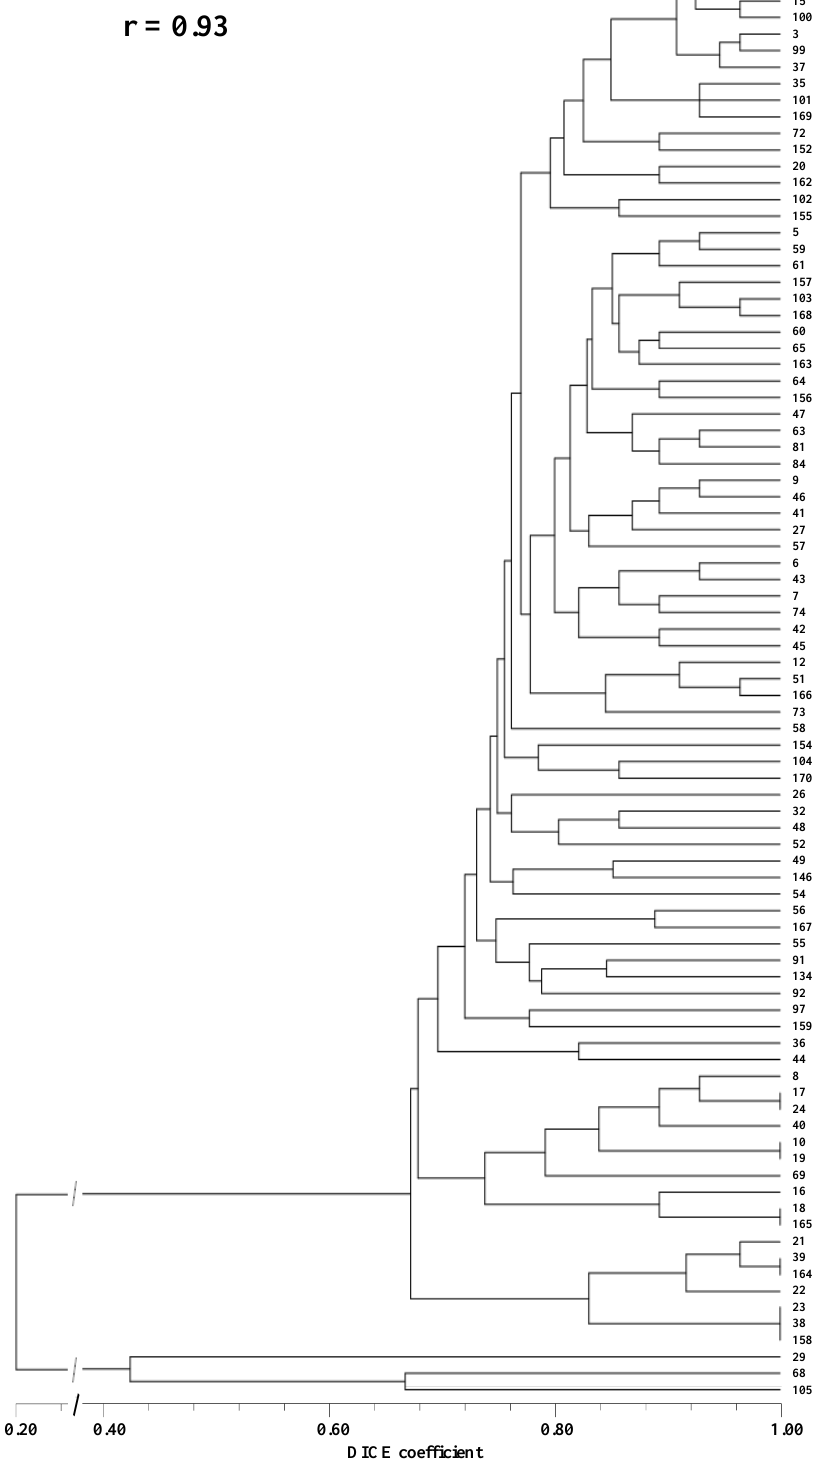
Figure 6. Dendrogram depicting the genetic relationships among the 90 germplasm accessions established based on SSR and SNP-CAPS markers. The Eruca sp. accessions (29, 68, and 105 at the bottom), used as an outgroup, are clustered apart from all the other ( D. tenuifolia ) accessions.